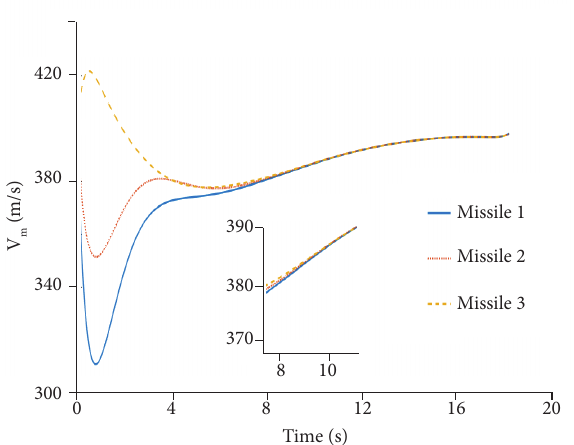
Figure 10. Flight path angles of the interceptors obtained using the regular cooperative control strategy.